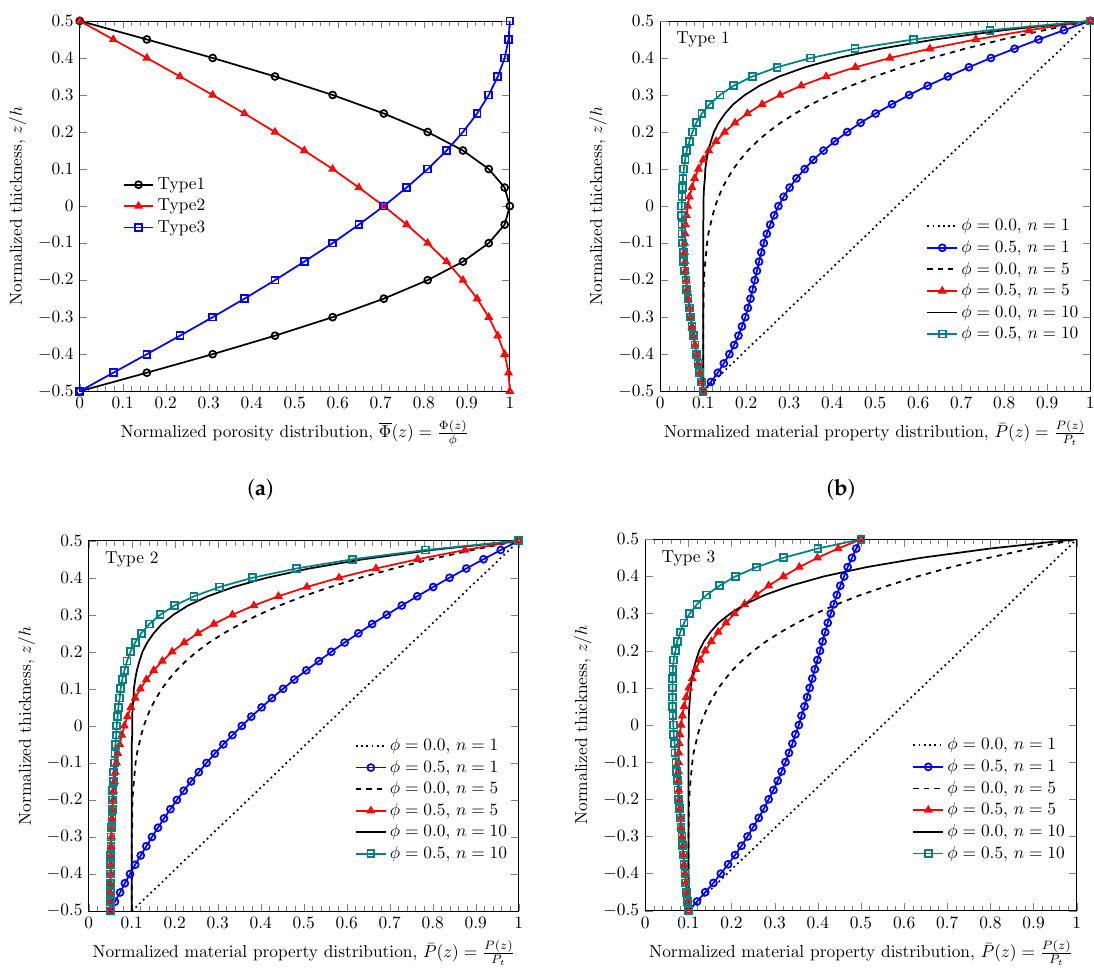
Figure 1. The normalized porosity distribution through the plate thickness ( a ) and normalized material property resulted from Type 1 distribution ( b ); Type 2 distribution ( c ); and Type 3 distribution ( d